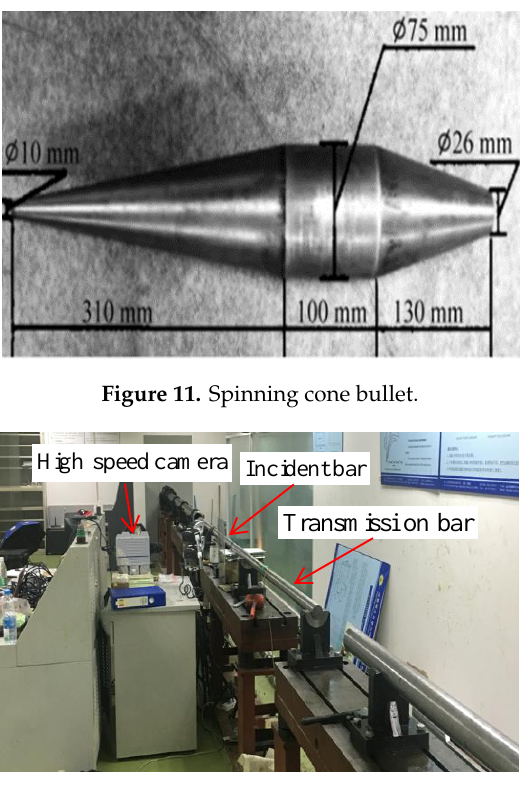
Figure 12. 50 mm split Hopkinson pressure bar (SHPB) experimental device.